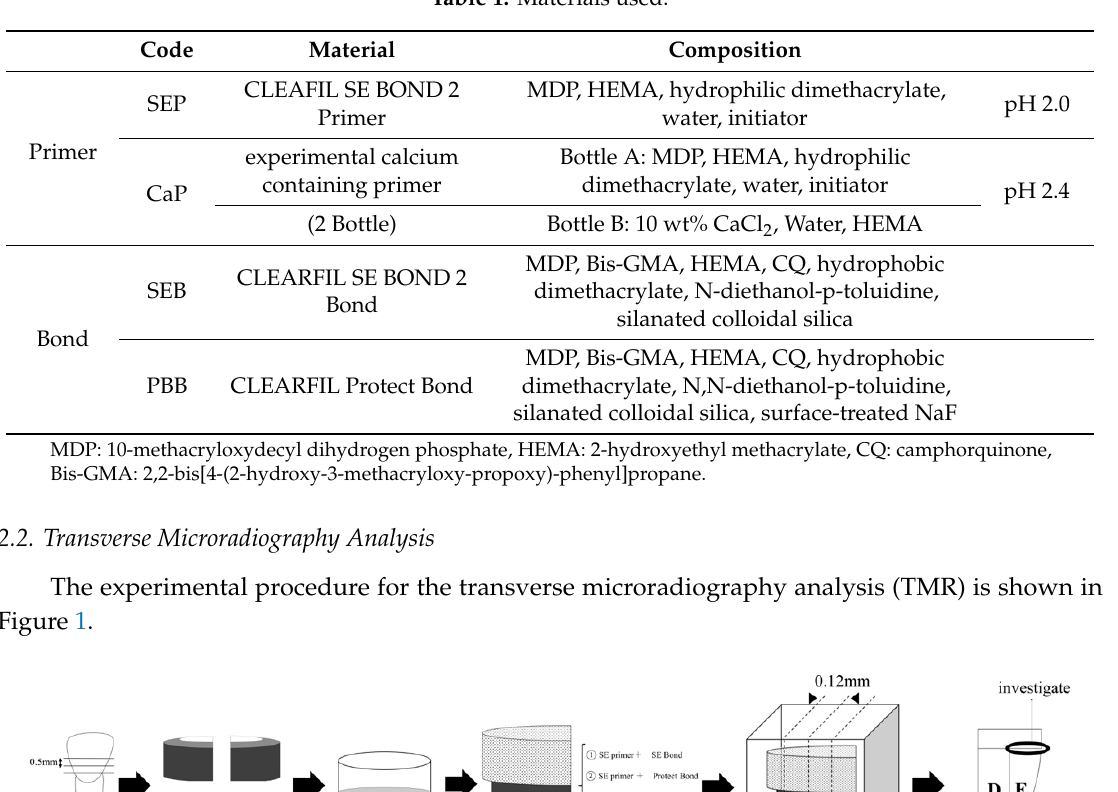
Table 1. Materials used.